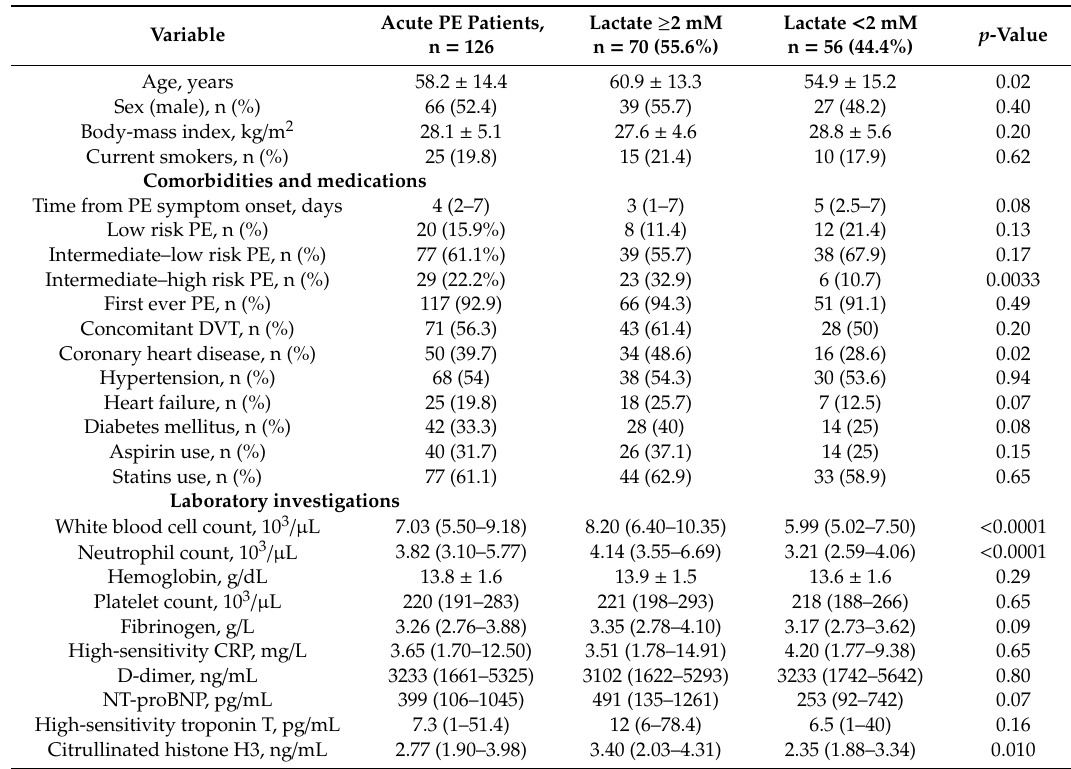
Table 1. Characteristics of patients with acute pulmonary embolism (PE) stratified according to serum lactate